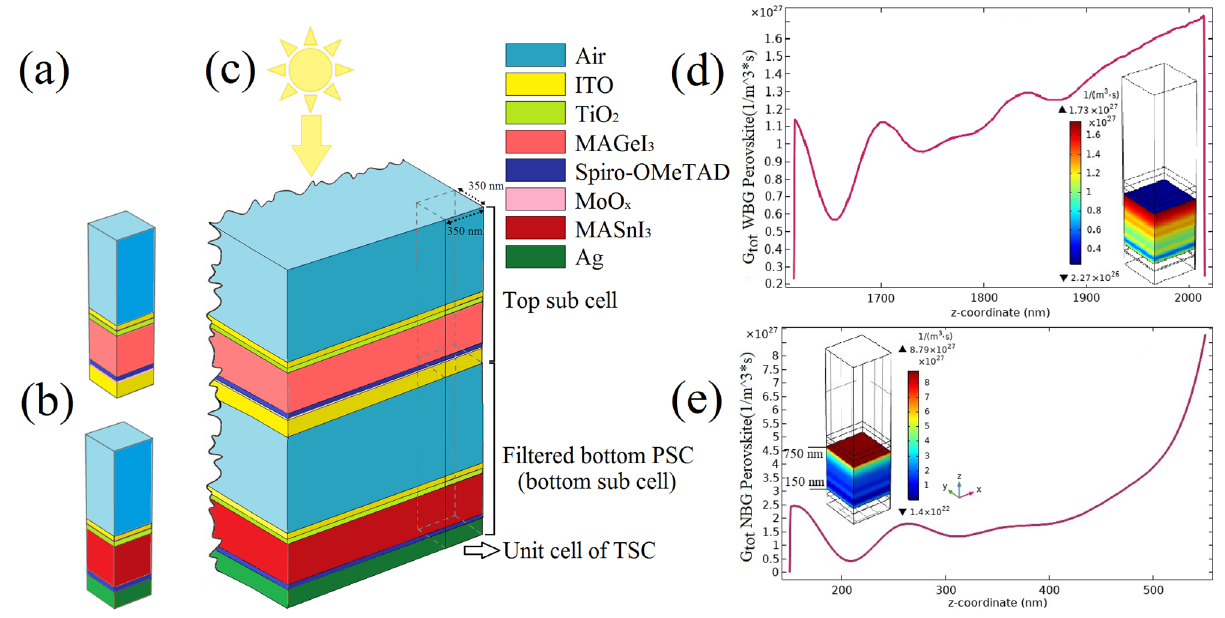
Figure 1. A schematic of the unit cell of single junction WBG PSC ( a ), stand-alone NBG PSC ( b ) and 4T APTSC ( c ). The total charge carrier generation rate versus perovskite layer length (along with the z-coordinate) and 3D map of total generation rate for single junction WBG PSC ( d ) and stand-alone NBG PSC ( e ).